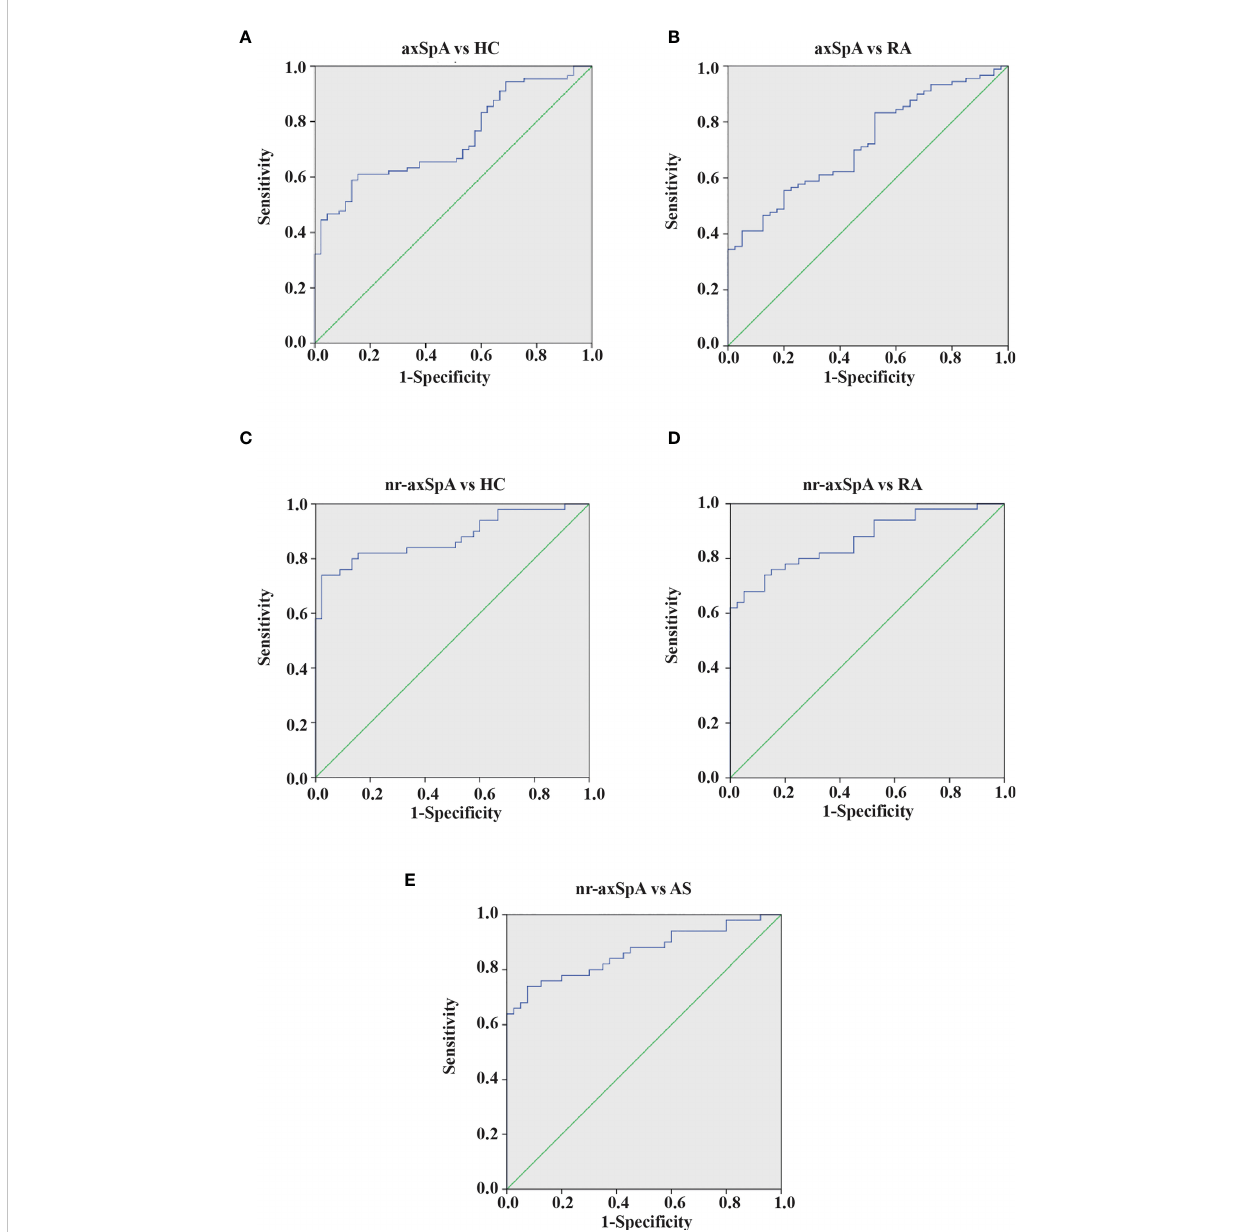
FIGURE 3 ROC curves of anti-Kaiso autoantibody for the discrimination of patients with axSpA from controls. (A) Patients with AxSpA (nr-axSpA and AS) versus healthy controls. (B) Patients with AxSpA versus RA. (C) Patients with nr-axSpA versus healthy controls. (D) Patients with nr-axSpA versus those with RA. (E) Patients with nr-axSpA versus those with